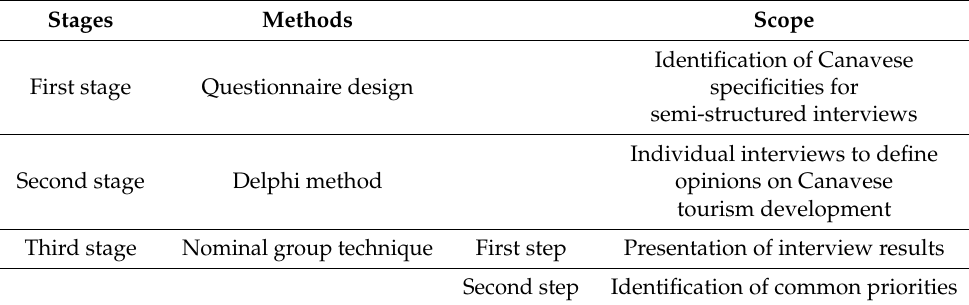
Table 2. Stages of the qualitative analysis involving the